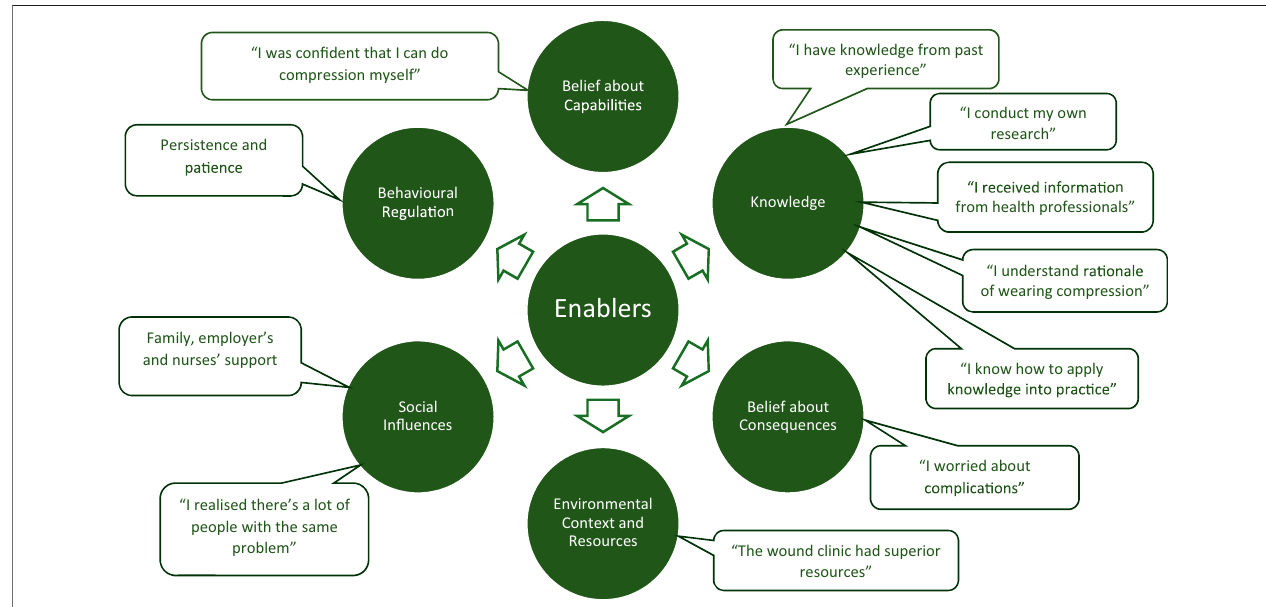
FIGURE 3 | Enablers to patients ’ adherence to the venous leg ulcer treatment